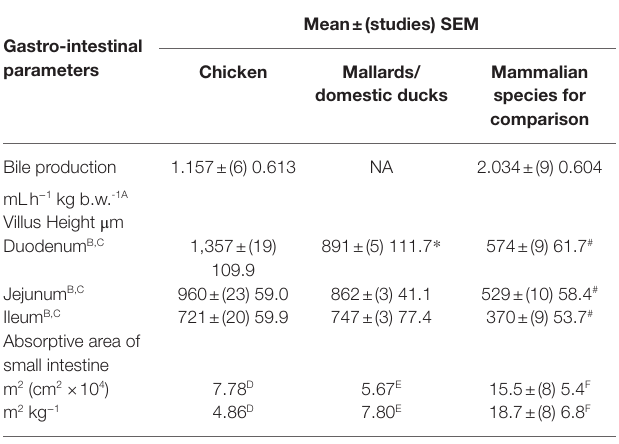
TABLE 6 | Gastro-intestinal and accessory organ parameters in chickens compared to those in mallards and mammals.